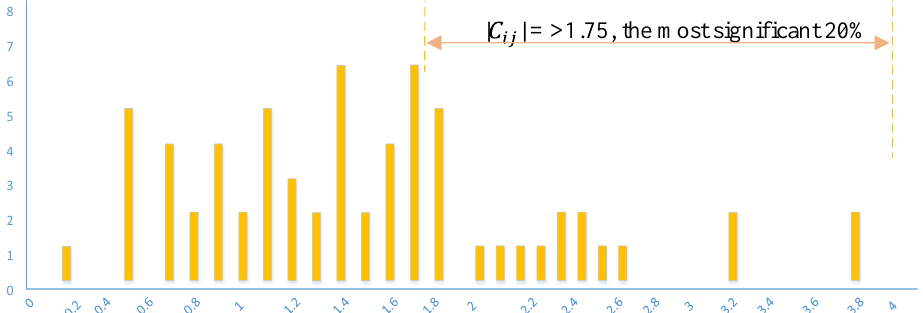
Figure 5. Histogram of | 𝐶 𝑖𝑗 |.